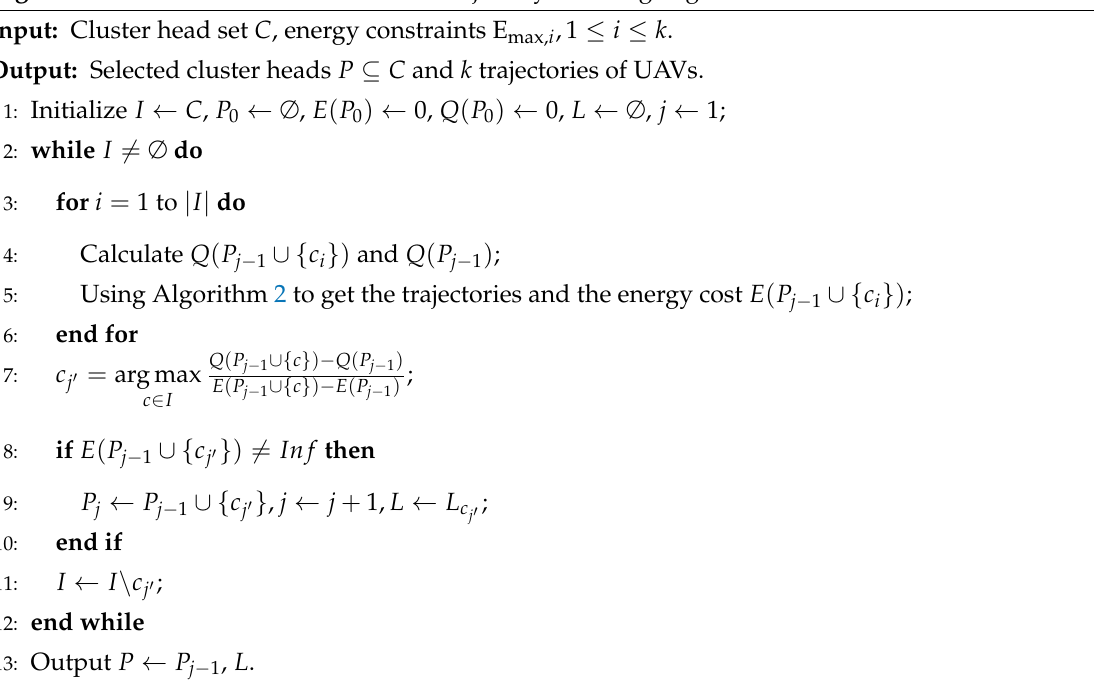
Algorithm 1 Cluster Head Selection and Trajectory Planning Algorithm